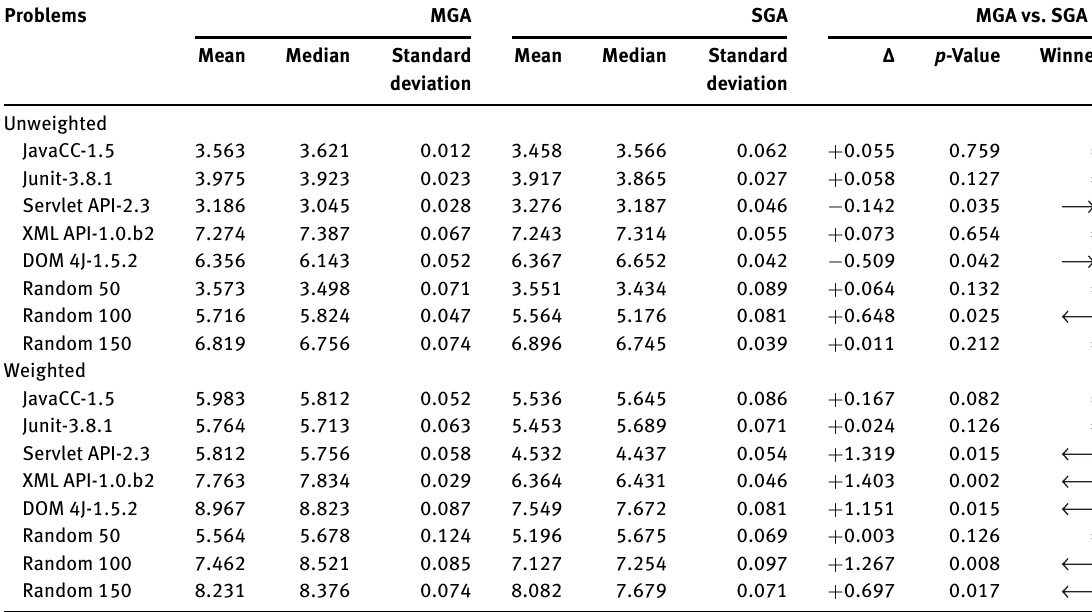
Table 3: Mean, Median and Standard Deviation of MQ Measure Obtained by Penalized Optimization.